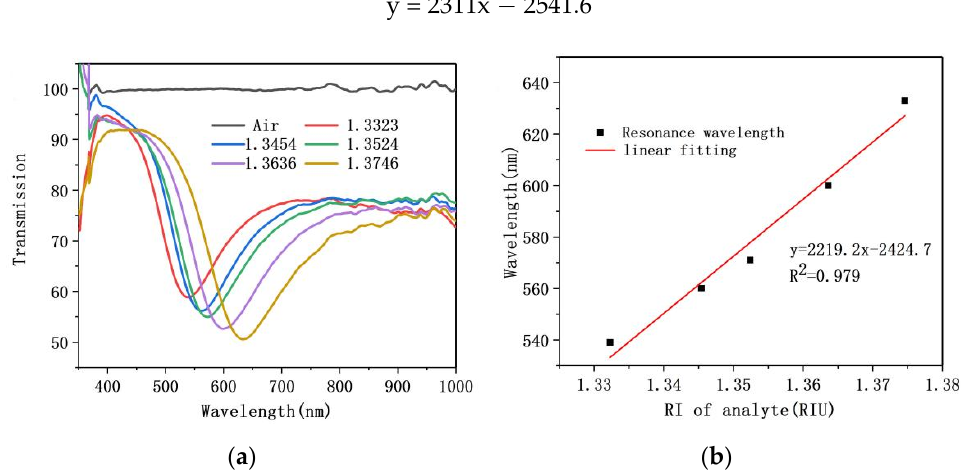
Figure 7. ( a ) The resonance spectrum of fiber/Ag film SPR sensor with sodium chloride solution as analyte; ( b ) The sensitivity fitting curve.